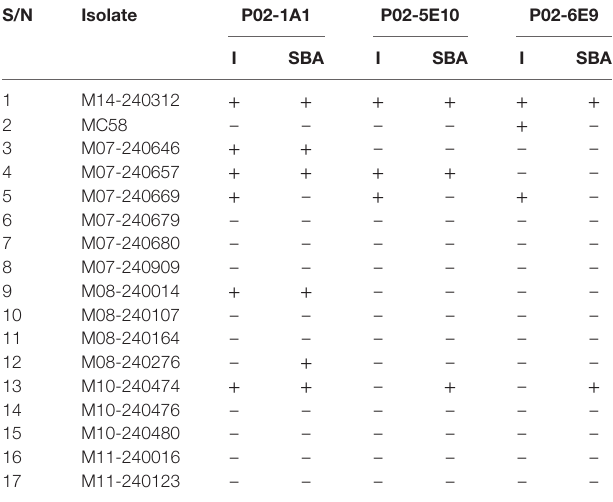
TaBle 2 | Summary table showing reactivity of the bactericidal human monoclonal antibodies—P02-1A1, P02-5E10, and P02-6E9—in immunoassays (ELISA and western blot), and SBA activity versus the 17-strain MenB